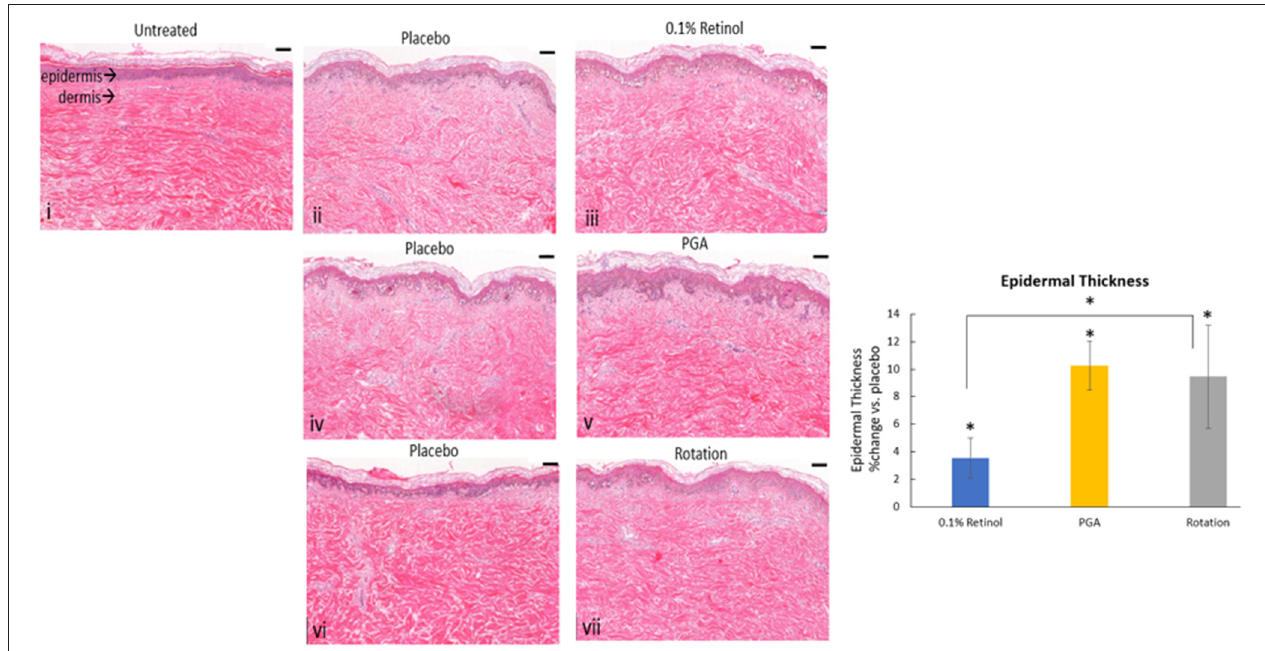
FIGURE 6 | The effect of rotational treatment on epidermal thickness in skin explants ex vivo . Skin explants ( n = 5) were treated (in triplicate) with continuous application of a single formula for 12 days or with two rounds of rotational application of each formula (per 3 days). Epidermal thickness was assessed by hematoxylin and eosin (H&E). All treatments increased epidermal thickness when compared to a placebo ( p < 0.05), while rotational treatment was significantly better than retinol formula alone. i: untreated, ii: placebo for retinol, iii: retinol, iv: placebo for 1% phytol/4% glycolic acid (PGA), v: PGA, vi: placebo for vii, and vii: rotation of iii and v. Scale bar = 100 µ m. *Means p < 0.05 or statistically significant result.